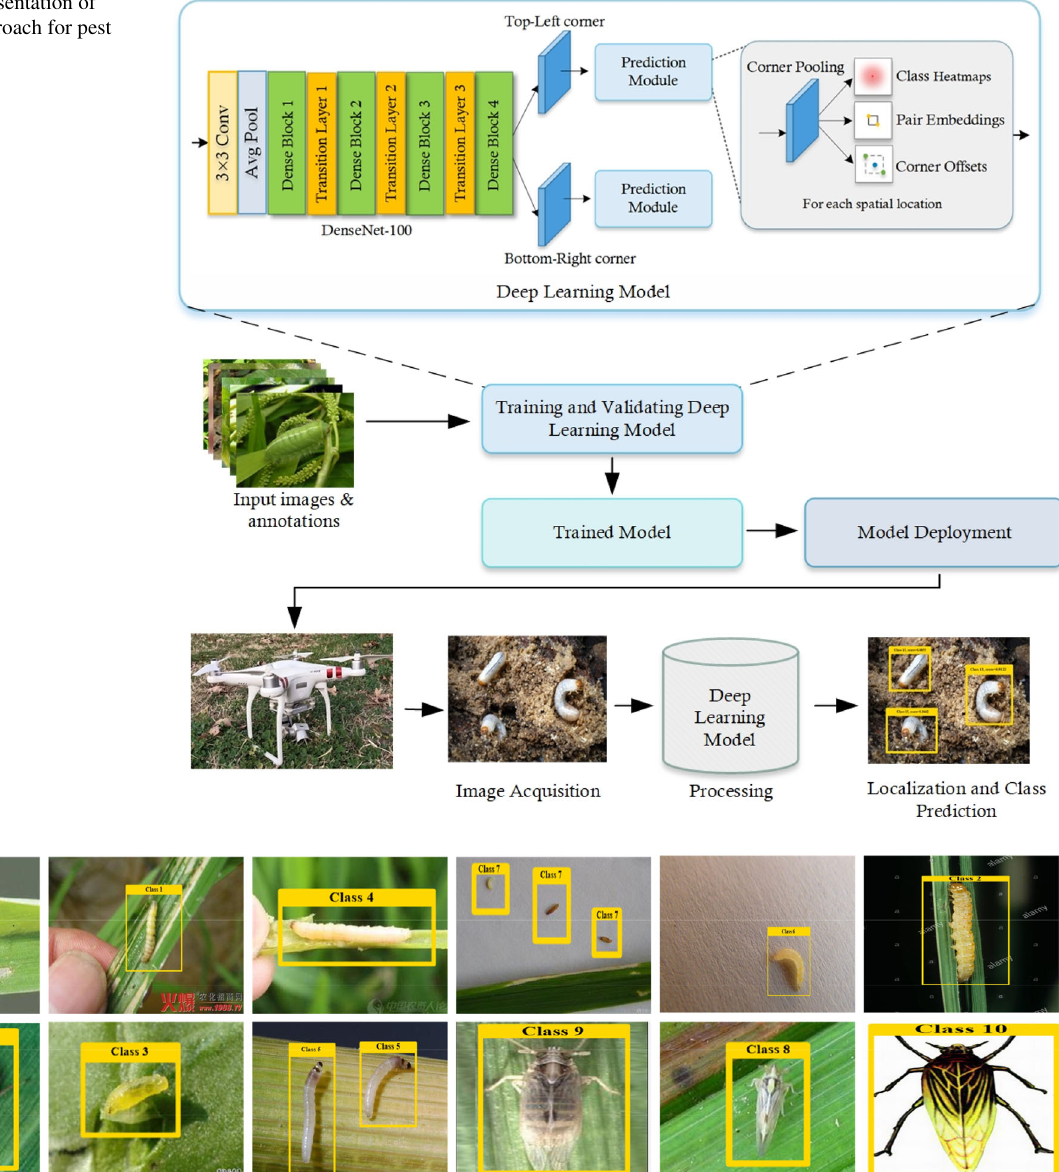
Fig. 2 Sample annotated images of the IP102 dataset